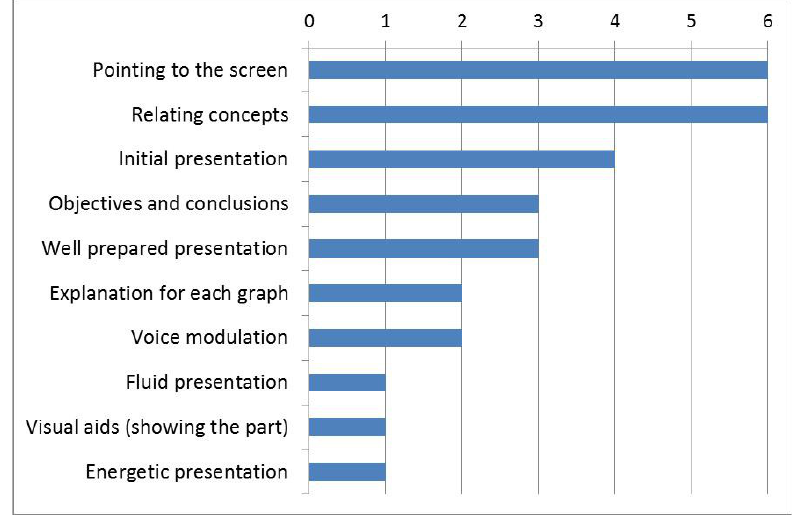
Figure 6. Positve issues in oral presentatons, according to the